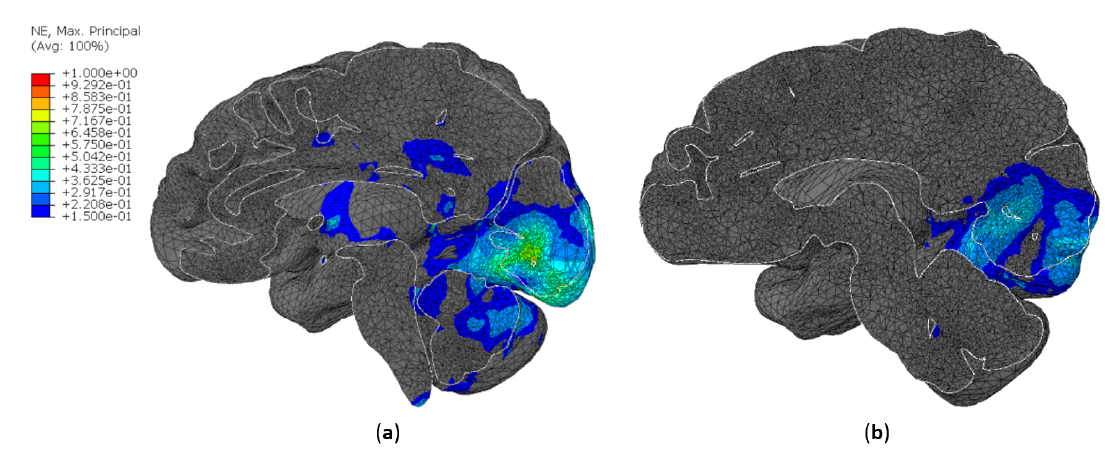
Figure 13. Brain strain distribution obtained with: ( a ) EPS liner. ( b ) AC